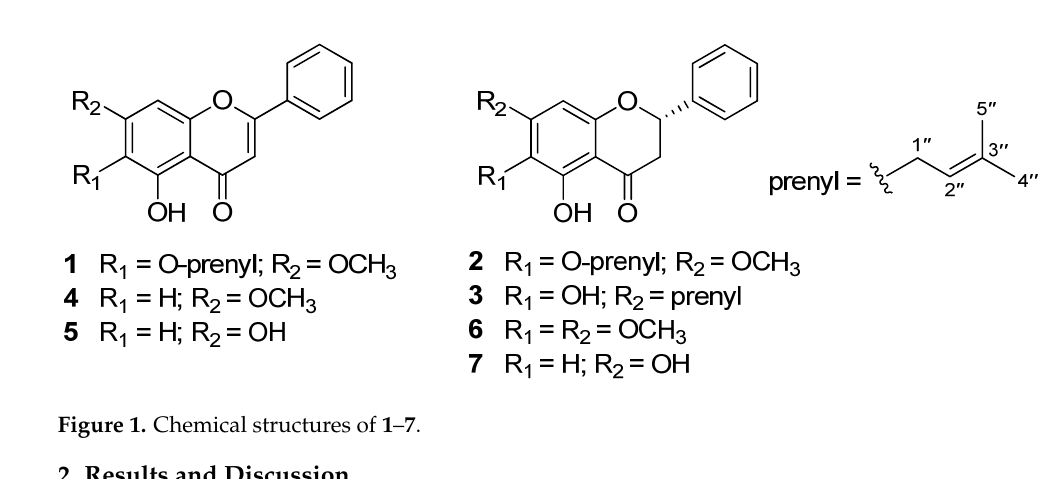
Figure 1. Chemical structures of 1-7 .